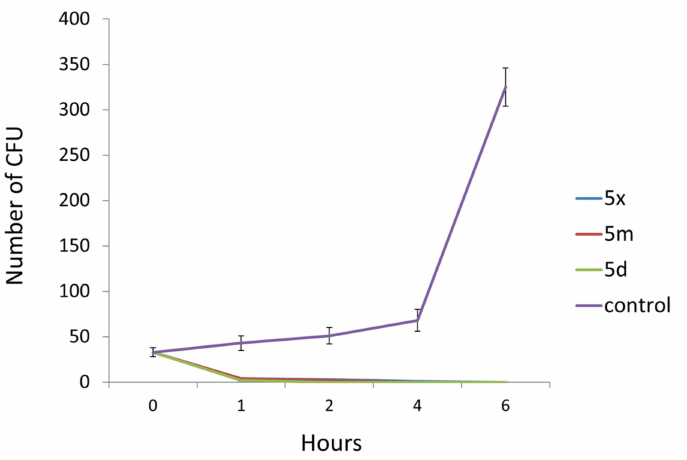
Figure 4. Number of P. aeruginosa CFU after different time intervals of antimicrobial treatment with MBC of tested